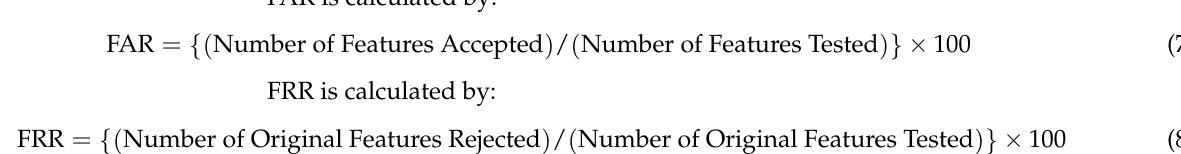
Figure 10. FRR calculation for different classifiers.